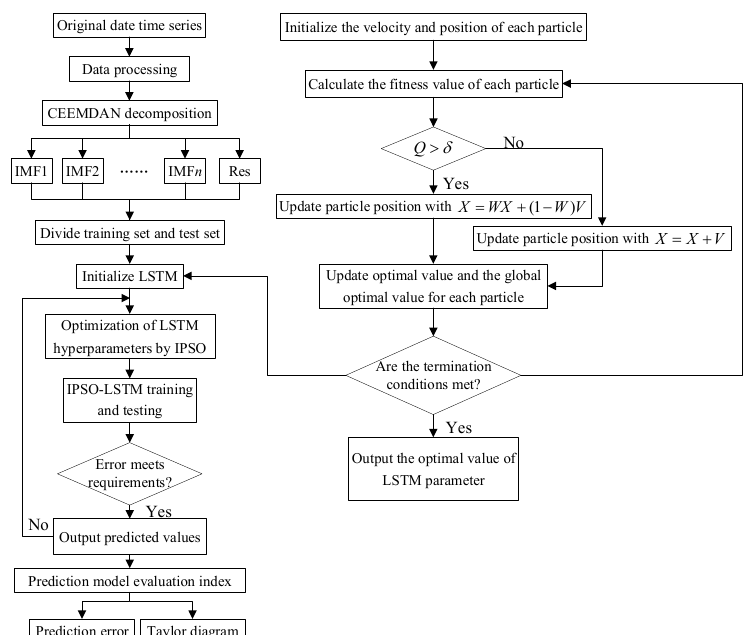
Figure 2. Flowchart of CEEMDAN ‐ IPSO ‐ LSTM prediction